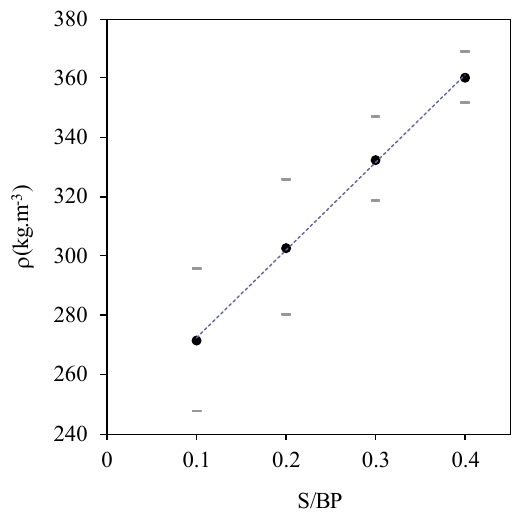
Figure 9. Apparent density evolution with S/BP mass ratio.